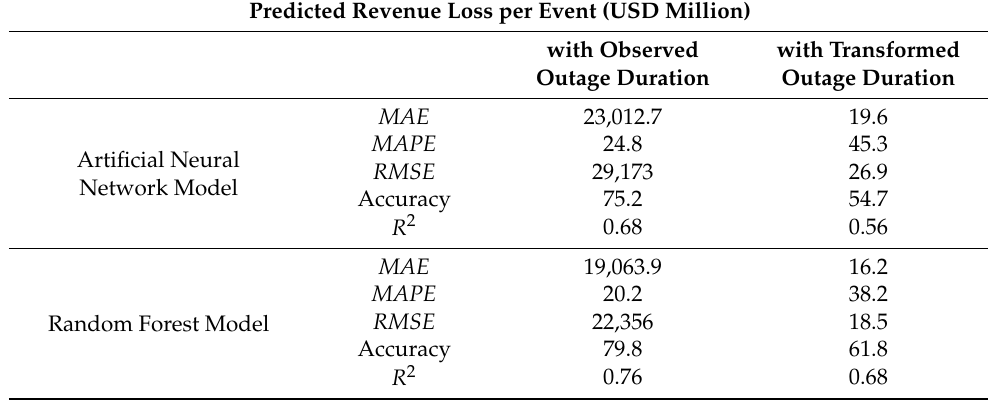
Table 4. Final revenue loss prediction results of machine learning algorithms.